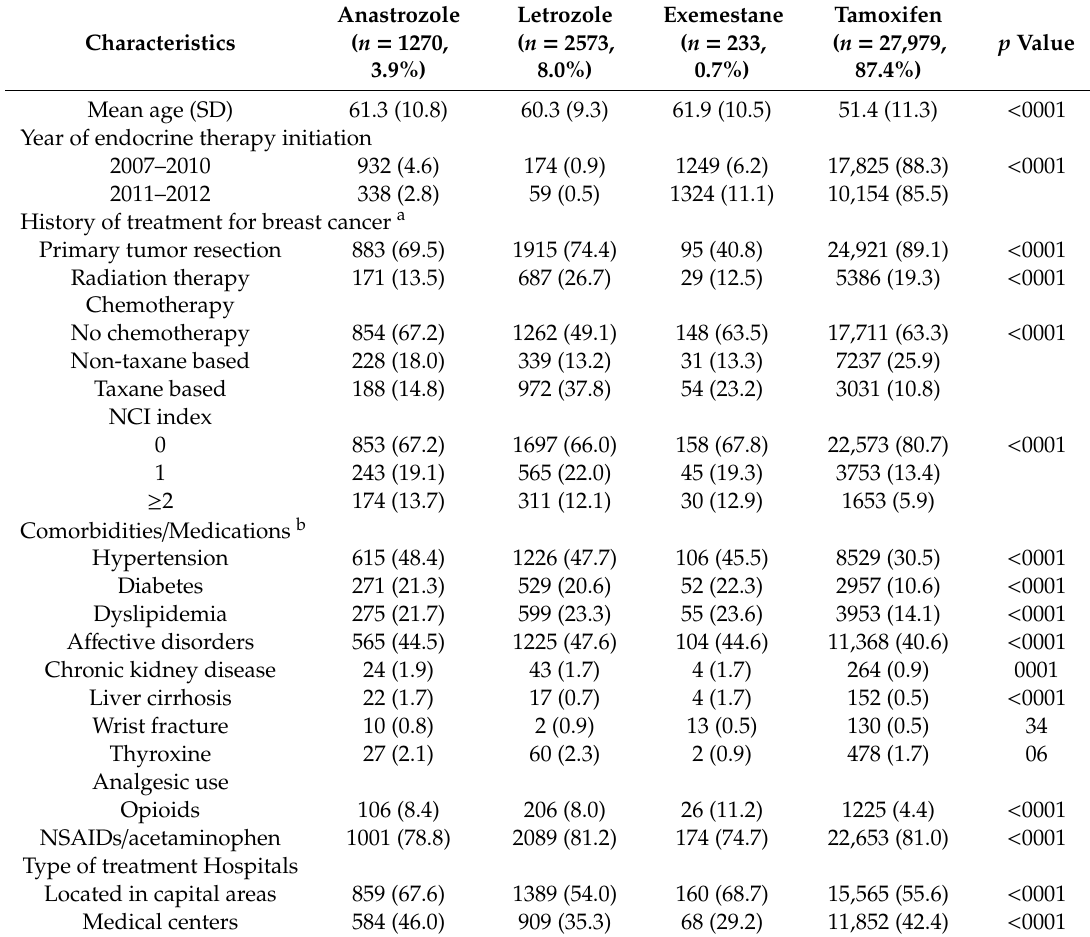
Table 1. Baseline Characteristics of Women with Breast Cancer by Initial Endocrine Therapy ( n =